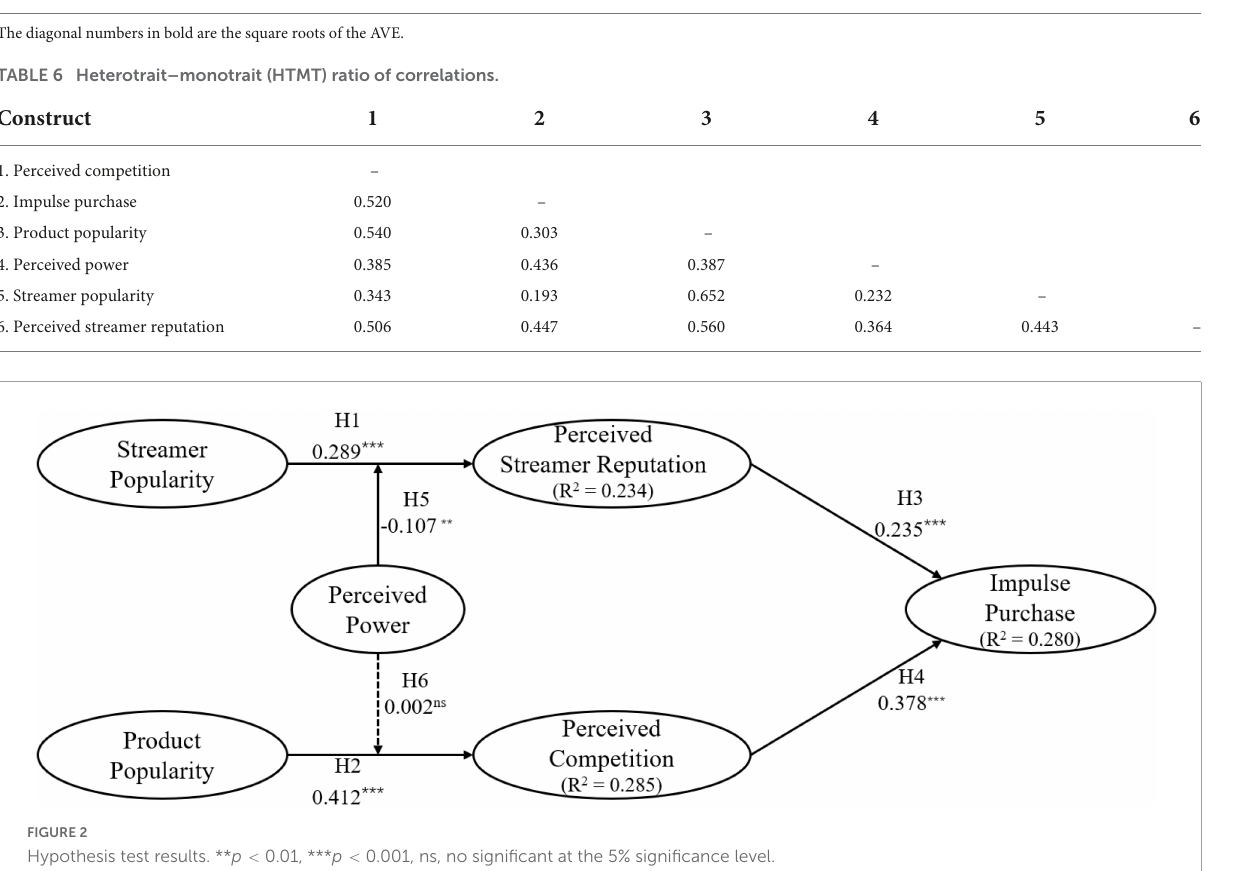
β = 0.378, p < 0.001), supporting H3 and